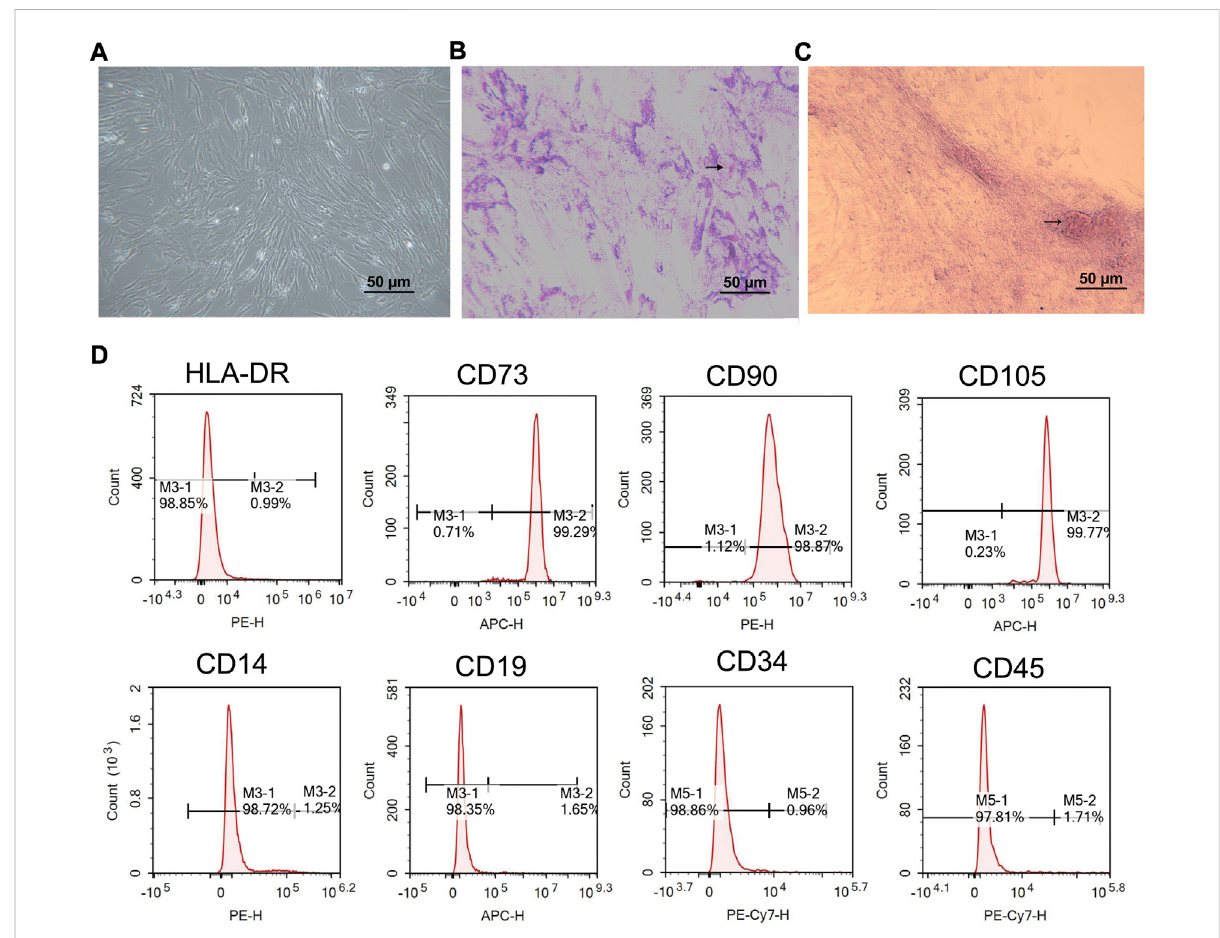
FIGURE 2 Characterization of hucMSCs. (A) Phase contrast picture of con fl uent huMSCs (×100). (B) Adipogenic differentiation observed with Oil Red O staining (×100). (C) Osteogenic differentiation observed with alizarin staining (× 100). (D) Flow cytometric analysis of hucMSCs speci fi c biomarkers. Scale bar = 50 μ m n =